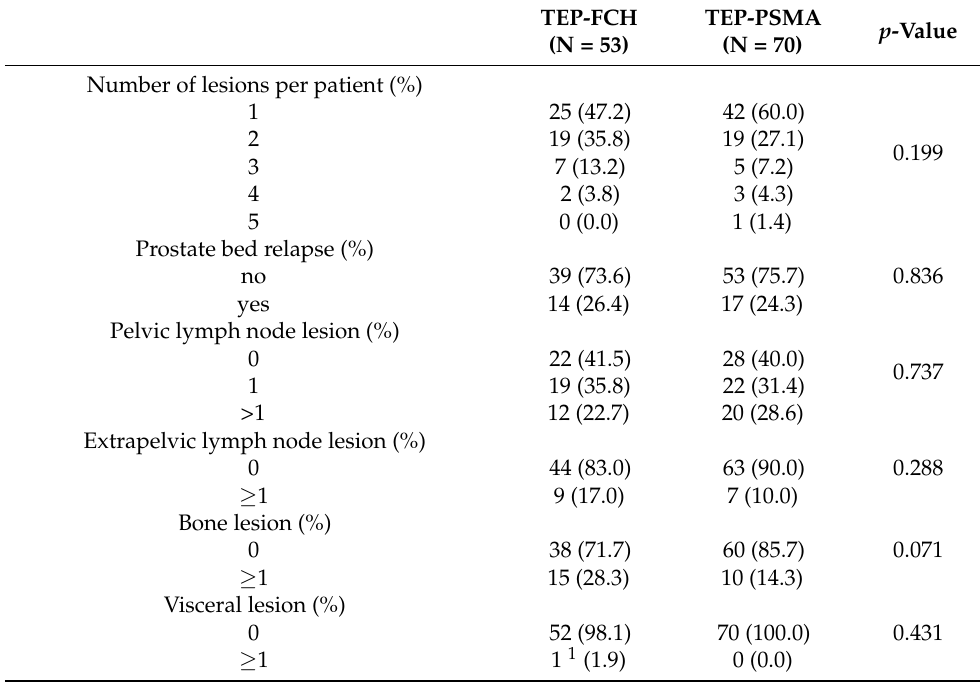
Table 2. Lesions characteristics detected by PET/CT.